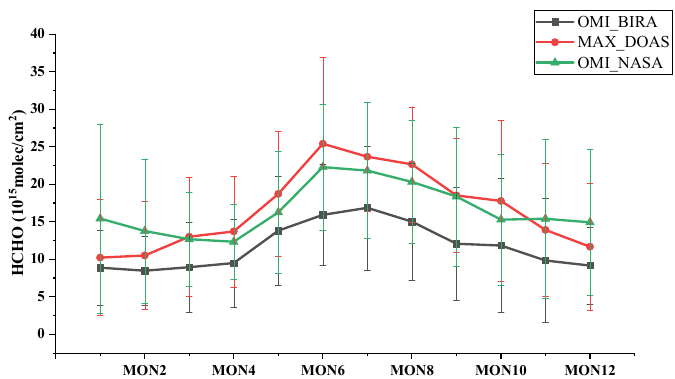
Figure 4. Monthly comparisons of OMI-BIRA and MAX-DOAS, and OMI-NASA and MAX-DOAS: ( a ) 2010–2016 monthly average; ( b ) 2010–2016 multi-year monthly average.